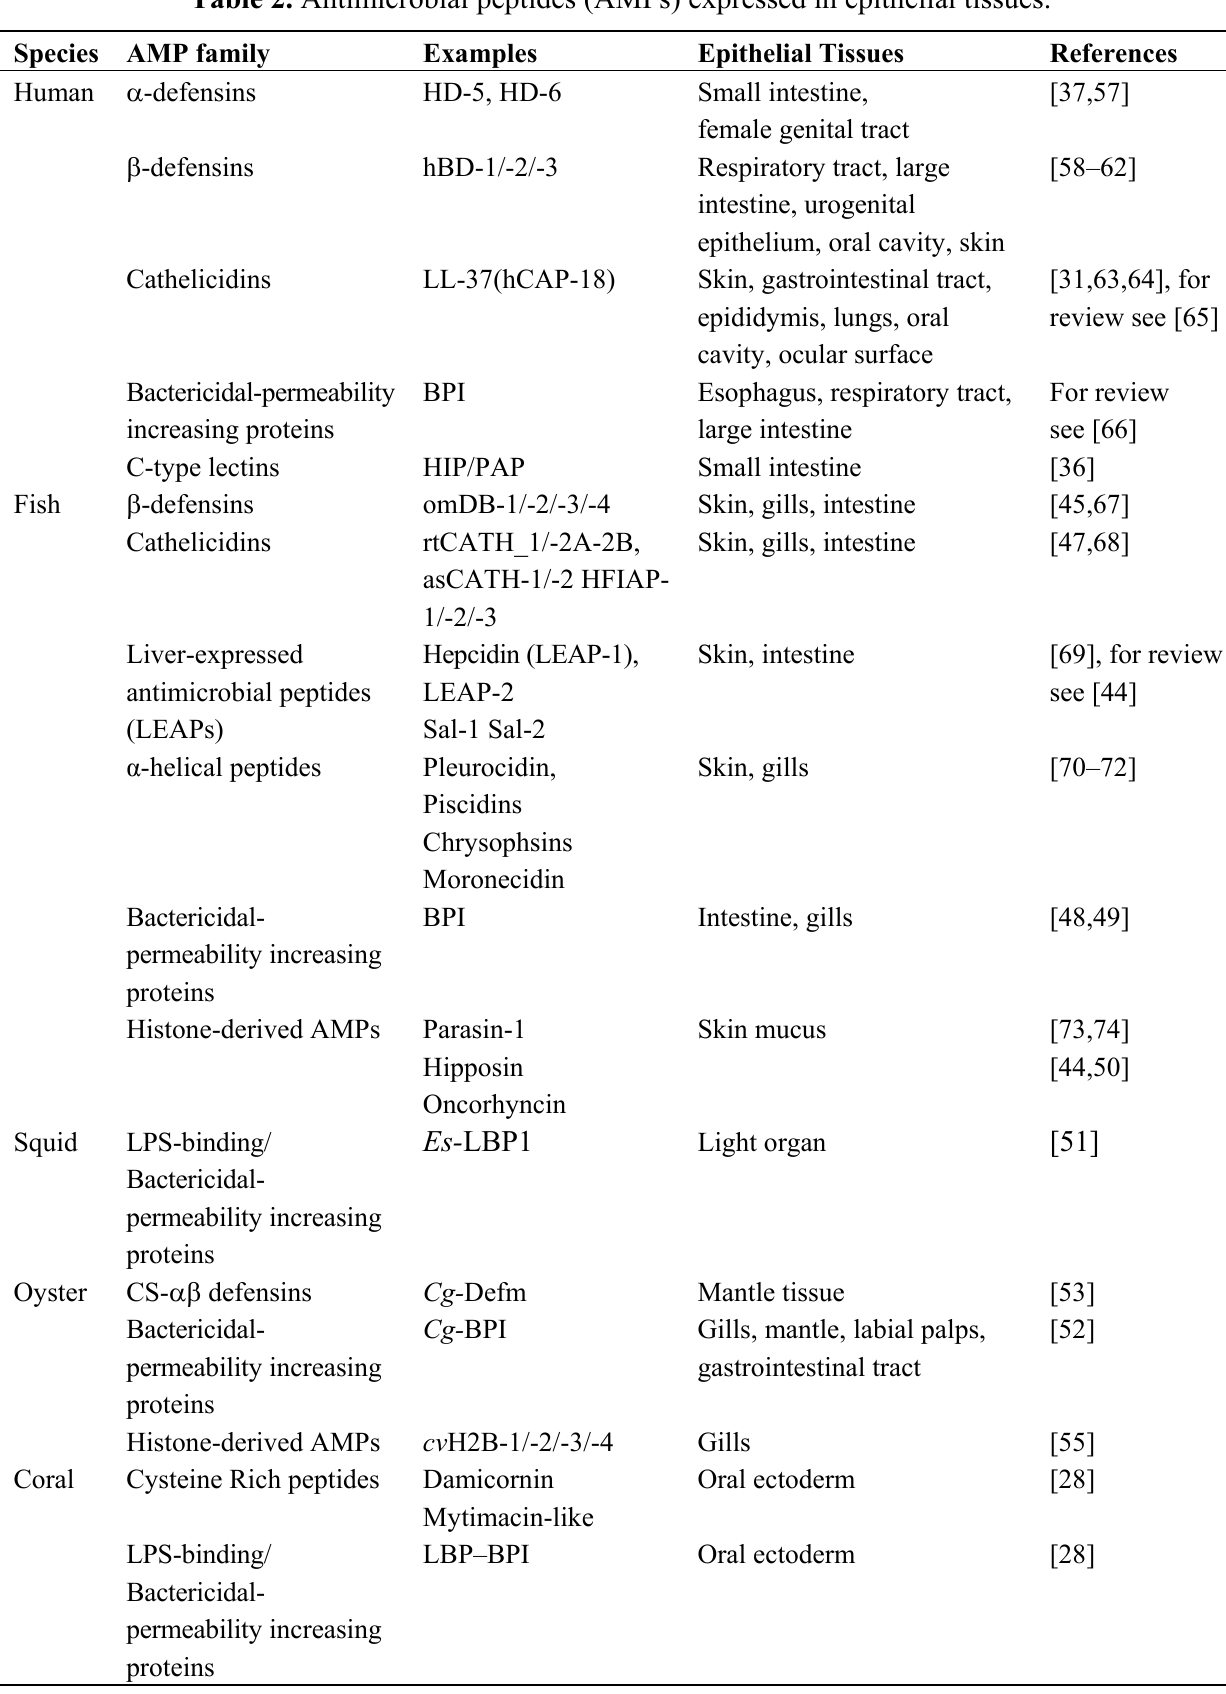
Table 2. Antimicrobial peptides (AMPs) expressed in epithelial